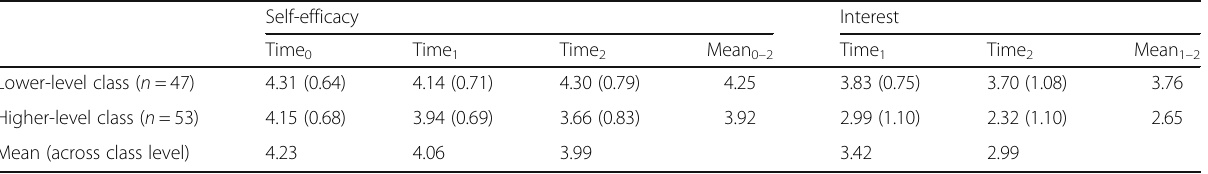
Table 1 Self-efficacy and interest scores across time points and grade levels Self-efficacy